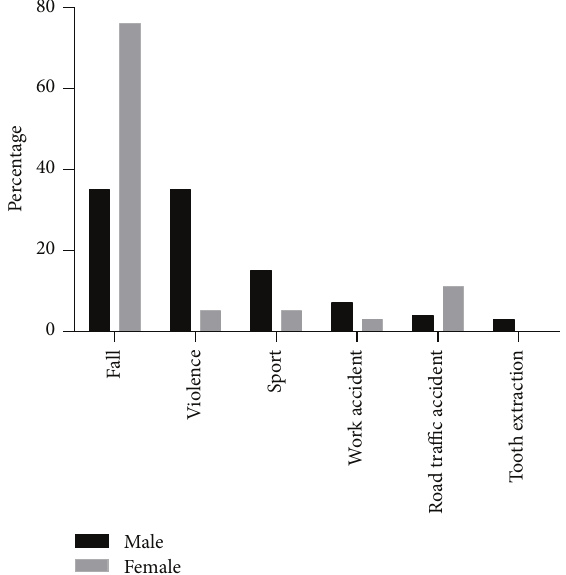
Figure 4: Cause of fracture for men (black) and women (grey) among all patients with one of the specified causes (men 𝑛 = 97 ; women 𝑛 = 38